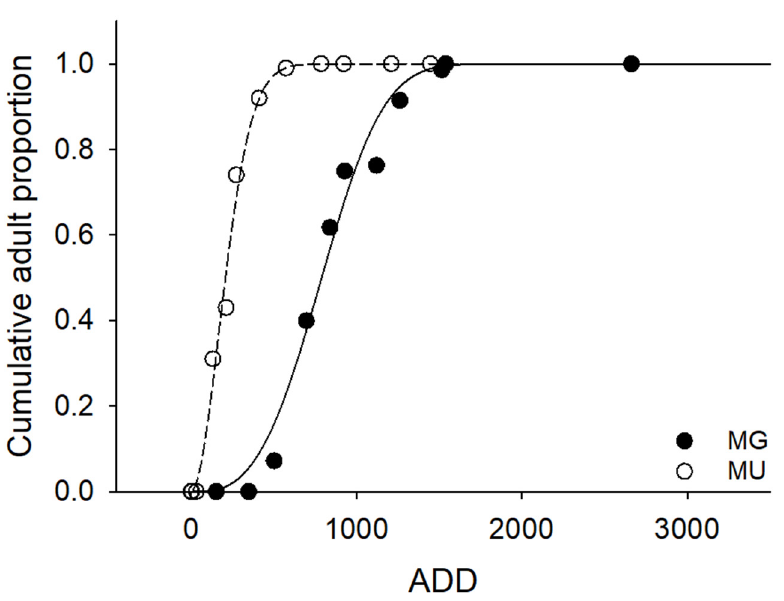
Figure 8. The cumulative proportion of Nannophya koreana adults at the two study sites (closed circle: MG, Mungyong-si; open circle: MU, Muui-do) during the study periods. The solid and dashed lines indicate the flight proportions predicted against ADD using 14.3 °C as the baseline (cid:104) (cid:105) − ( x /889.05 ) 3.07 temperature: the equations of the solid and dashed lines are f ( x ) = 1 − exp and (cid:104) (cid:105) − ( x /252.31 ) 1.88 f ( x ) = 1 − exp , respectively.